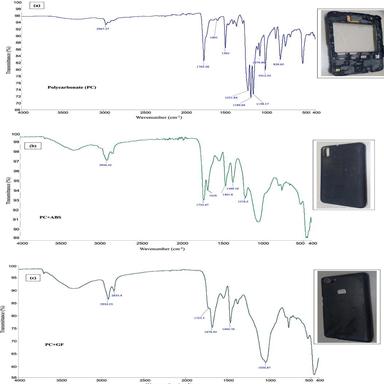
FTIR spectra of different types of polymers found in MPs: Casings: (a) Polycarbonate (PC), (b) Polycarbonate + Acrylonitrile butadiene styrene (PC + ABS), (c) Polycarbonate + Glass Fraction (PC + GF); Keypad: (d) Silicone; Display Module: (e) Polyethylene terephthalate (PET), (f) Polyurethane (PU), and (g) Polycarbonate (PC), (g).